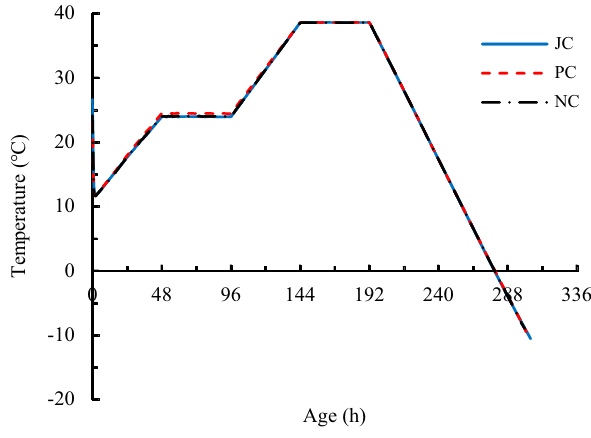
Figure 1: Schematic diagram of the designed TMC and CTC for guiding TSTM tests of the three face - slab concretes.